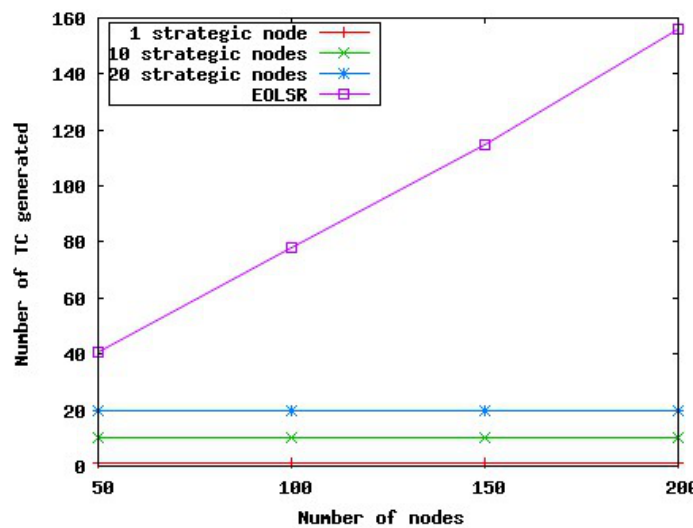
Figure 5. Number of TCs generated in the